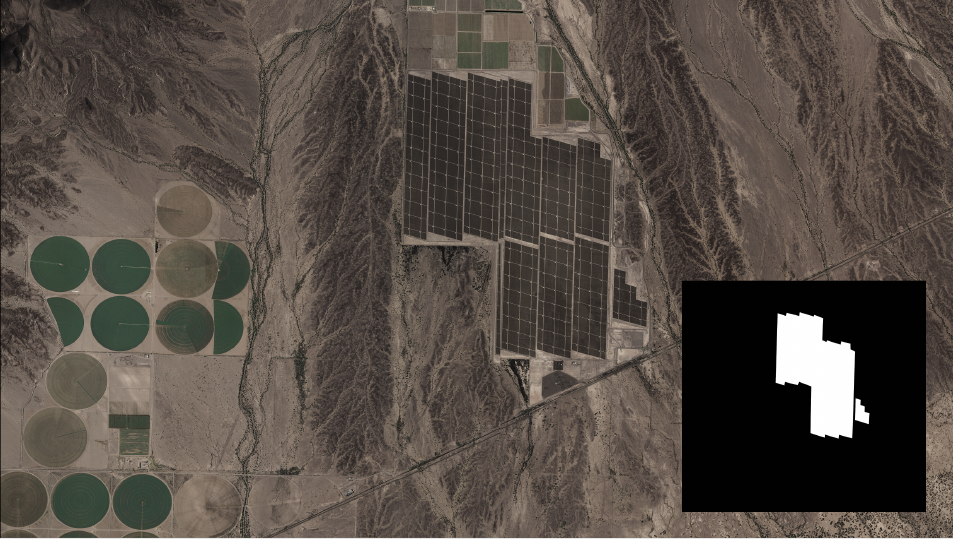
Figure A2. Agua Caliente (32 ◦ 57.2 (cid:48) N, 113 ◦ 29.4 (cid:48) W), California, along with its corresponding